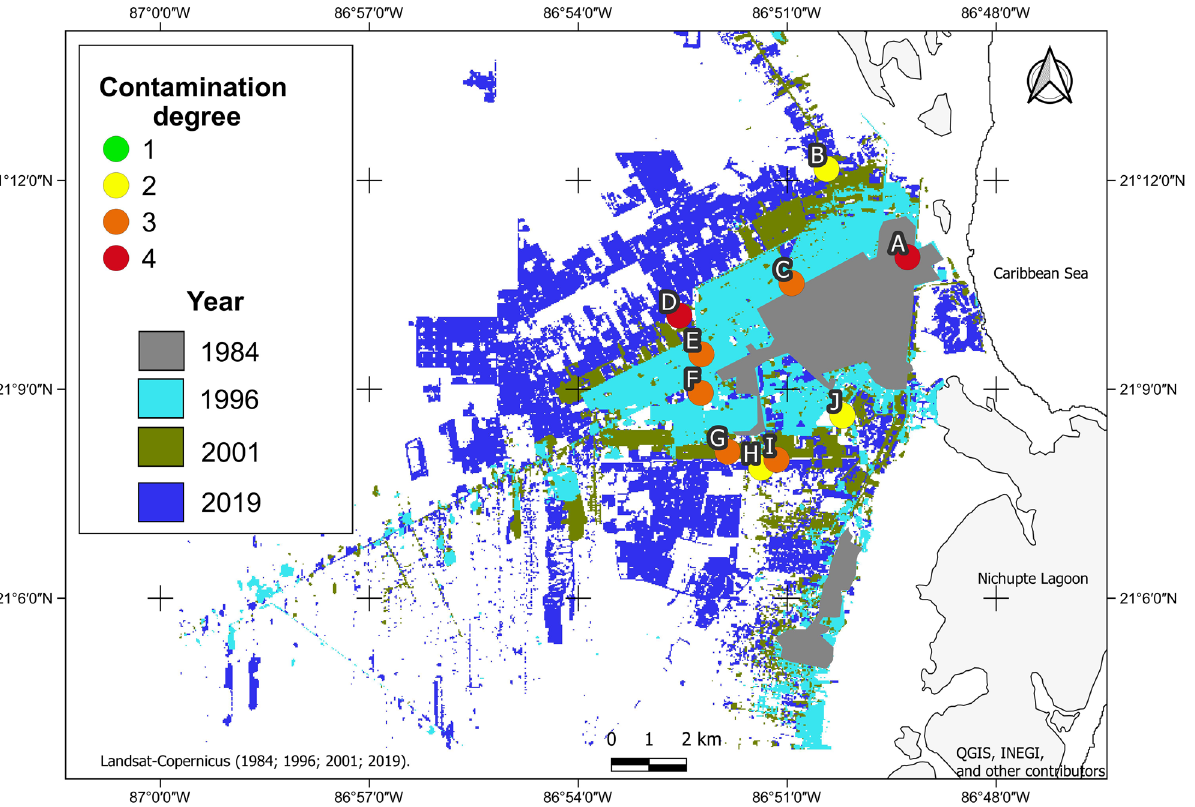
Figure 7. Degree of contamination of the sediments in the urban sinkholes in the study relative to urbanization time. The oldest areas in the city (dark gray) comprise sites with high degrees of contamination. Map generated with QGIS 3.14.1 [https:// www. qgis. org/ en/ site/]; vectorial layers from INEGI [https:// www. inegi. org. mx]. Landsat TM satellite images from 1984, 1991, 2001, and 2019 (with less than 30% cloud cover; http:// earth explo rer. usgs. gov/) were obtained and cropped (area of interest) and a supervised classification was applied with QGIS version 3.14.1, with two classes: City and Other land